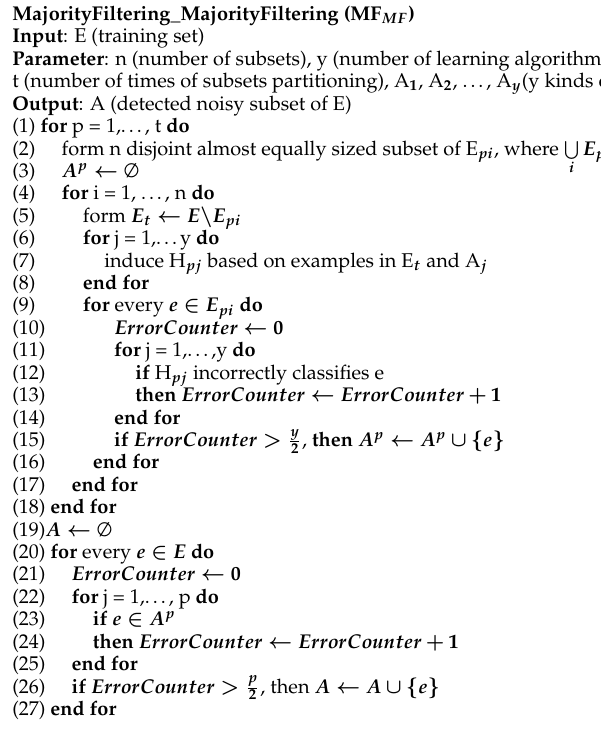
Algorithm 2 MF MF